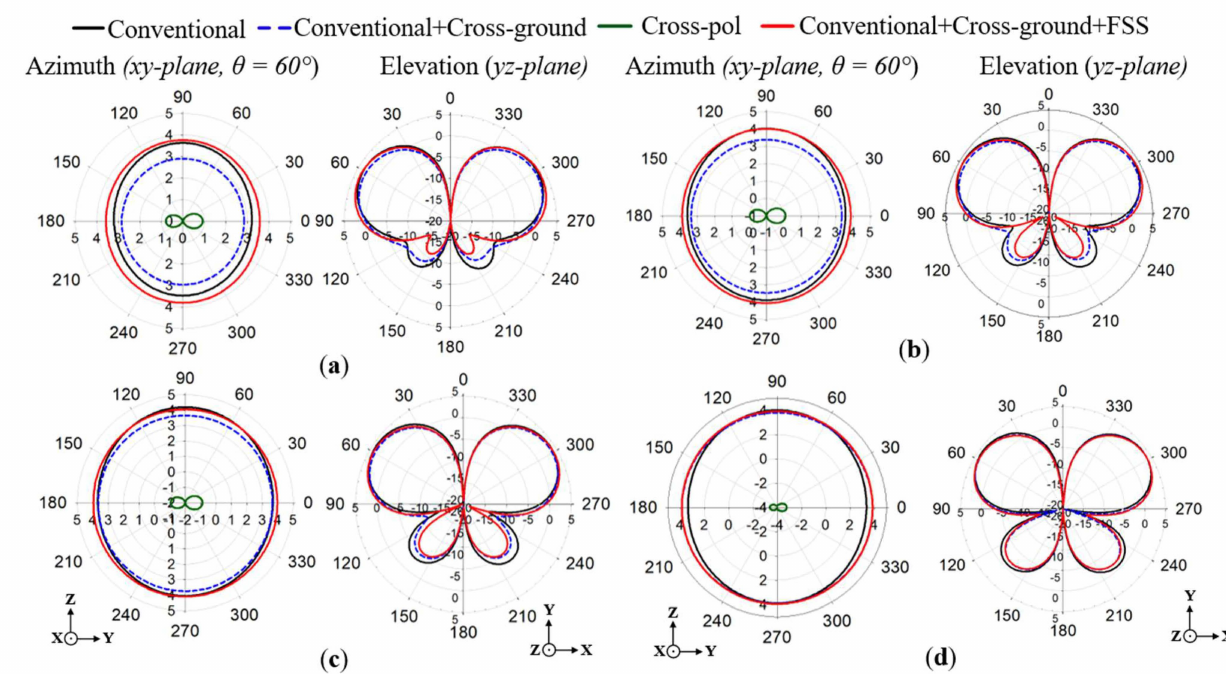
Figure 11. Simulated results of the azimuth and elevation radiation patterns for ( a ) 1.7, ( b ) 1.8, ( c ) 1.86, and ( d ) 2 GHz.